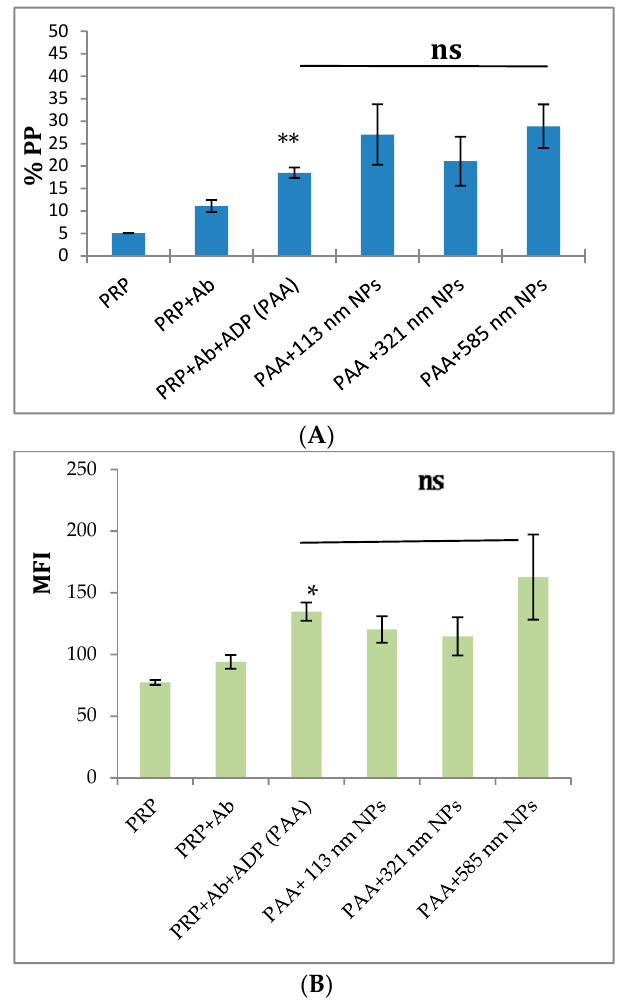
Figure 3. Flow cytometry analysis of the effect of size on PLGA ‐ PEG NPs, at 2.2 mg/mL, on ADP activation of PRP. ( A ) % Positive platelets (% PP); ( B ) Mean fluorescence intensity (MFI). Data are the average of n = 3–5 ± SEM. The NPs were pre ‐ incubated with aliquots of platelets in PRP, followed by activation using 20 μ M ADP. Samples were, then, incubated in the presence of CD62P antibody (10 μ g/mL). % Gated platelets represent the percentage of CD62P ‐ positive platelets in the total platelet population. * p < 0.05, ** p < 0.01 as compared with PRP+Ab+ADP (control), one ‐ way ANOVA followed by post hoc Tukey test, ns = not